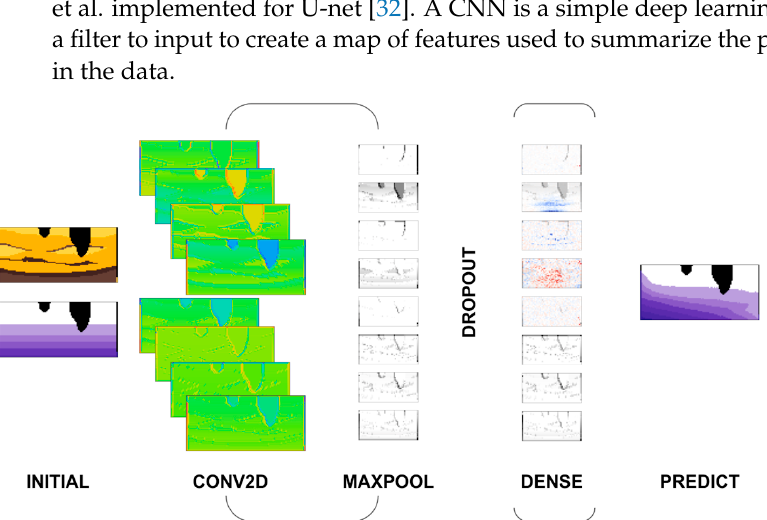
Figure 9. CNN with a coupled convolutional and pooling layer followed by a dense layer to predict the pressure at the next time step.